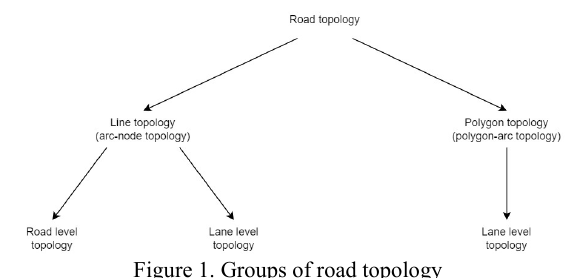
Figure 1. Groups of road topology